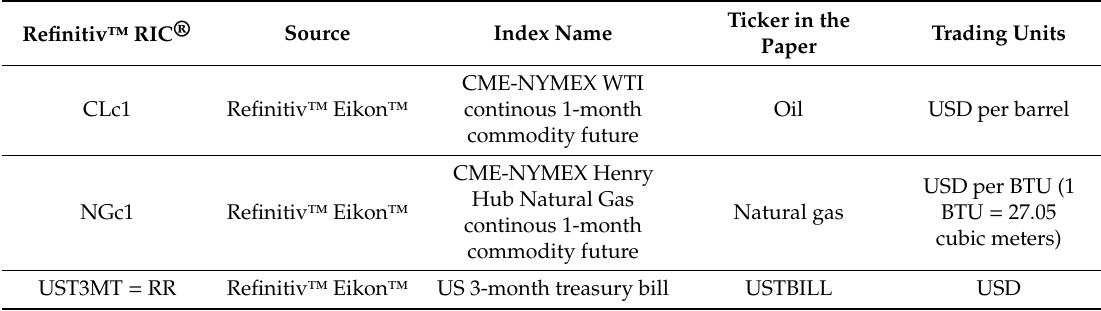
Table 1. Summary of the time series used as input in our simulations, their tickers, price-contract size relation and